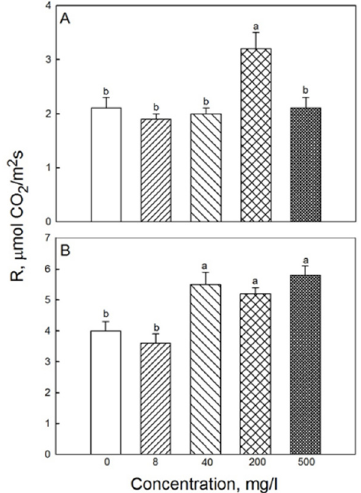
Figure 3. Effects of seed treatment with various concentrations of Fe 3 O 4 nanoparticles on respiration (R) in ( A ) second and ( B ) third leaves of 19-day-old wheat plants grown at a light intensity of 300 µ mol (photons) m − 2 · s − 1 . Data are means ± SD ( n = 5). Data labelled with different lower-case letters are significantly different at p < 0.05.